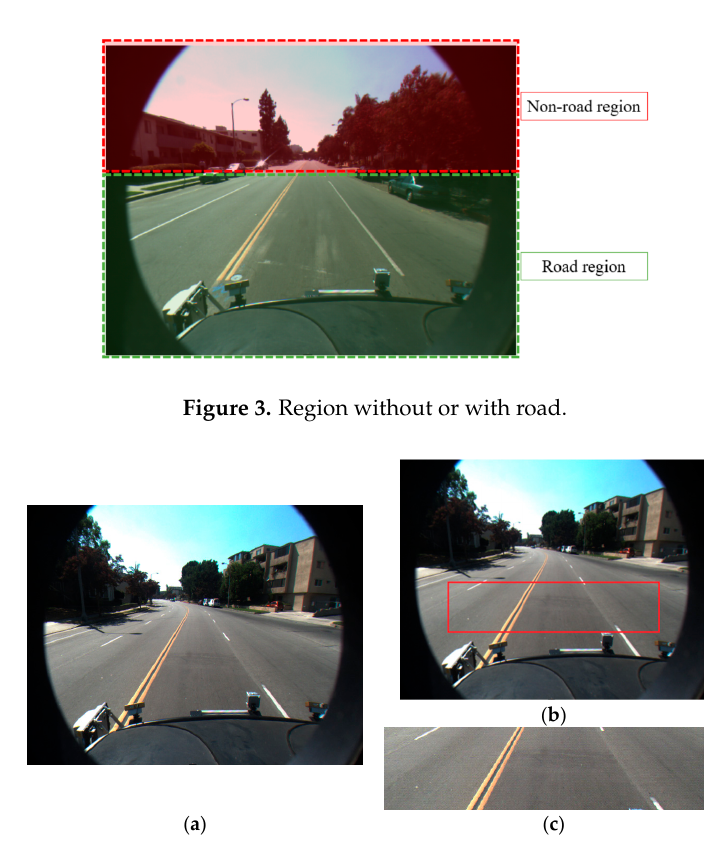
Figure 4. Defining the region-of-interest (ROI) in input image: ( a ) input image; ( b ) ROI; and ( c ) ROI image.